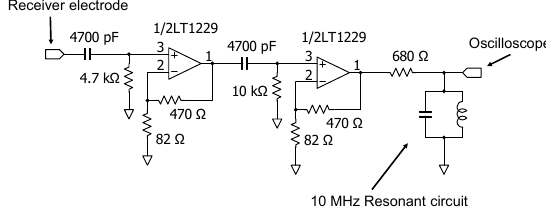
Figure 5. Circuit diagram of receiver